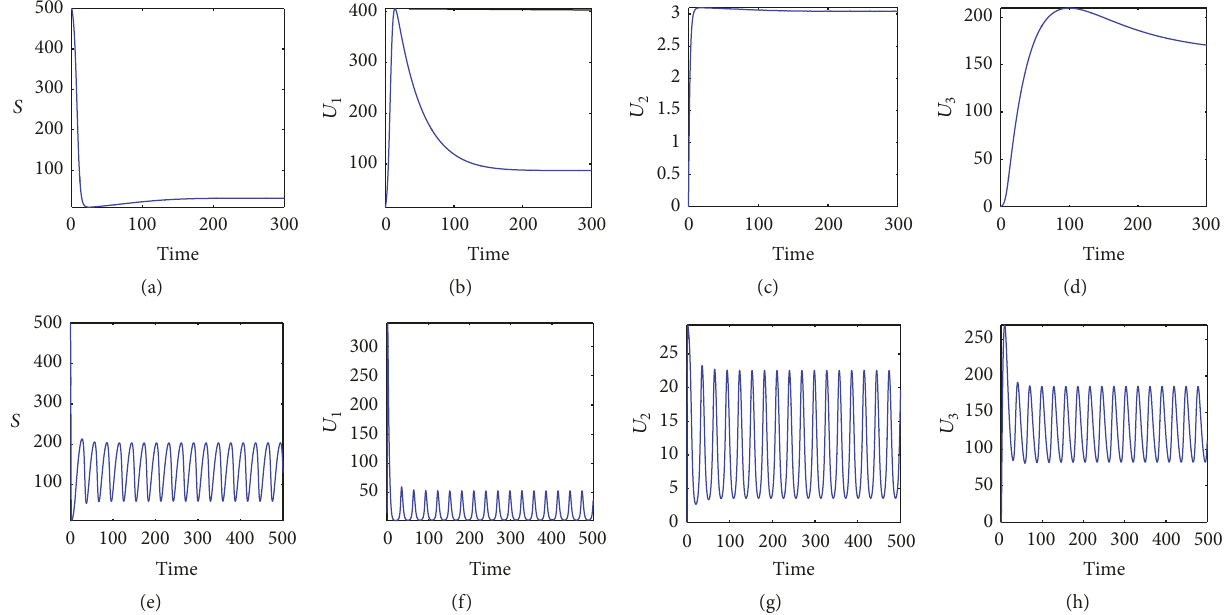
Figure 7: Illustration of validity of global stability condition. (a), (b), (c), and (d) represent a scenario where condition (67) holds true and global stability is predicted. (e), (f), (g), and (h) represent a scenario where condition (67) does not hold and oscillations are expected.